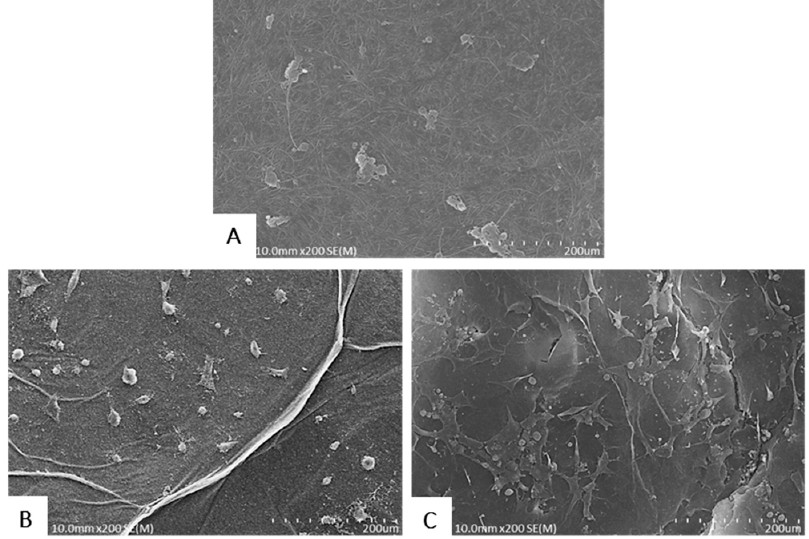
Figure 8. FE-SEM images of adherent cells on NI-BCMs ( A ), 100k EI-BCMs ( B ) and 300k EI-BCMs ( C ). Cells on NI-BCMs were localized, whereas the cell growth on EI-BCMs was induced by the nano-fibrous structure of BC and spread in random directions.